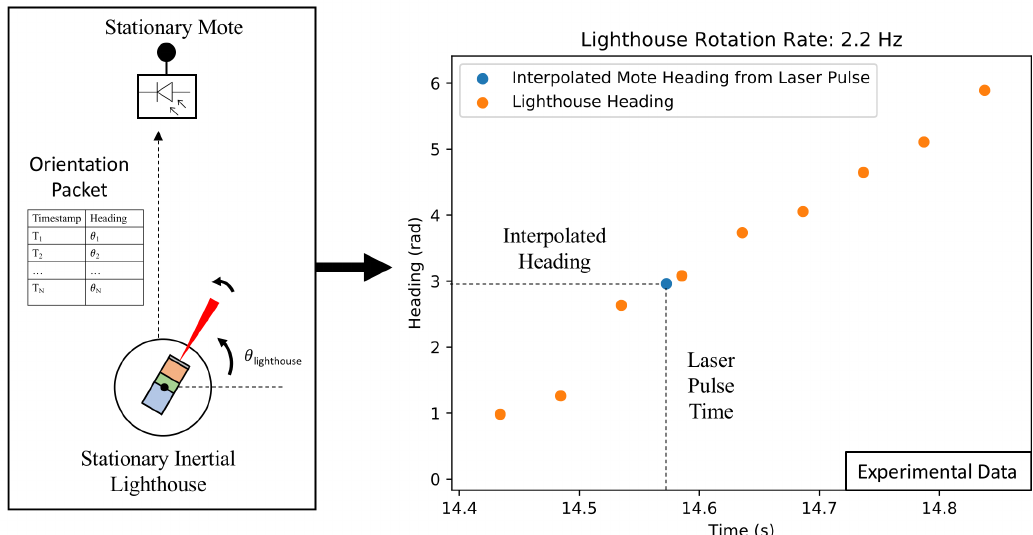
Figure 7. Calculation of bearing from laser pulse timing. Once a node detects a laser pulse and receives a localization EB, it can calculate its bearing relative to the lighthouse node by interpolating the surrounding lighthouse time-heading tuples and looking up the laser pulse time. This data was obtained during an experiment with a fixed-position lighthouse sensor node rotating and a stationary self-localizing sensor node. This heading data were produced with the on-board magnetometer on a MIMSY that was located